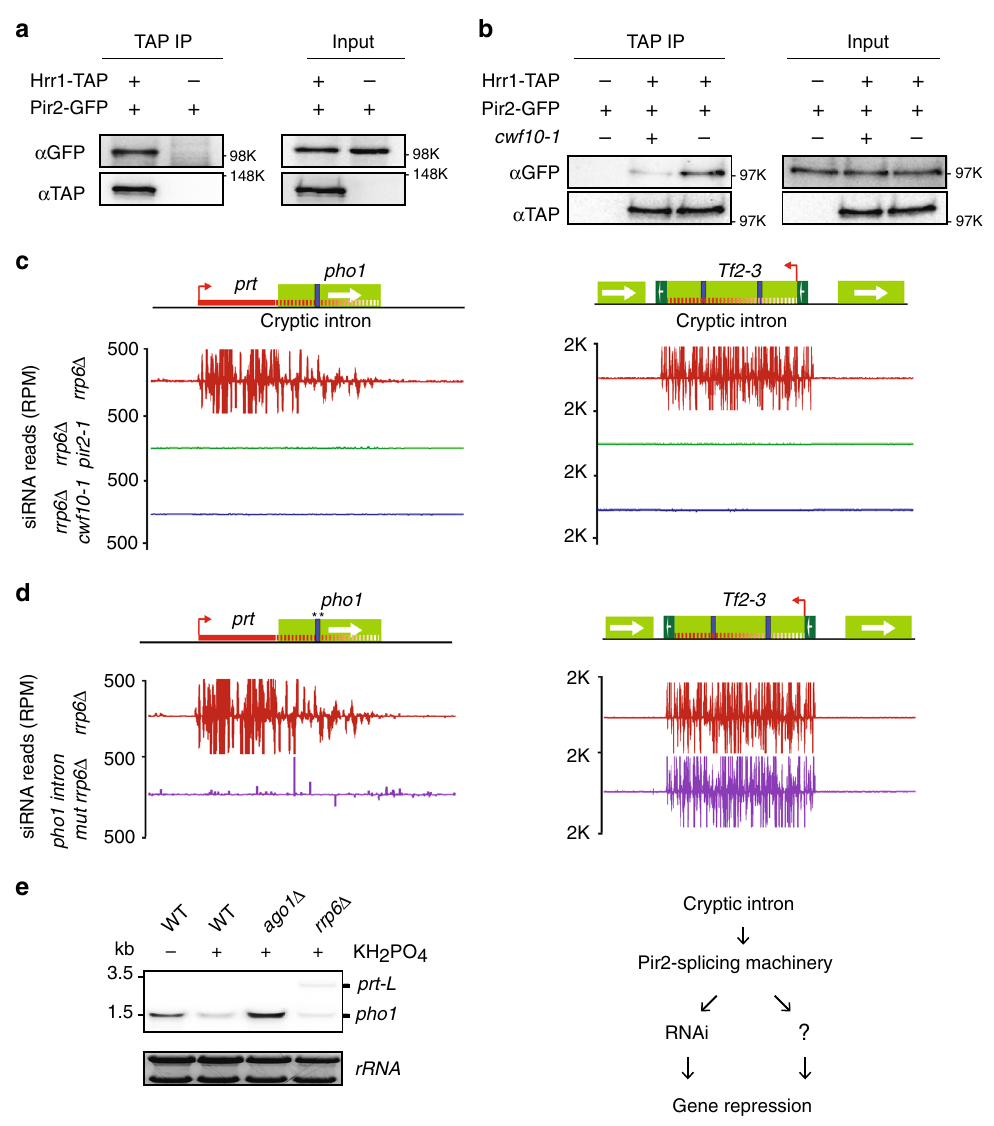
Fig. 4 Pir2 interacts with RNAi machinery required for lncRNA-mediated gene repression. a , b Co-IP analysis of Hrr1-TAP and Pir2-GFP proteins in the indicated strains. Source data are provided as a Source data fi le. c The normalized number of siRNA reads are plotted in alignment with pho1 and Tf2-3 loci. The signal above and below the line represent siRNAs that map to the top and bottom strands, respectively. TopHAT splice junctions of introns emerging in the strains are indicated by blue arcs. d Normalized number of siRNAs mapping to pho1 and Tf2-3 loci in rrp6 Δ (red) and rrp6 Δ cells carrying the splice site mutation in the cryptic intron in prt-pho1 (purple). The cryptic intron is marked by a blue box and stars indicate mutation sites. e Northern blot analysis of the pho1 gene. Cells were grown in EMM medium with or without phosphate. The radioactive probe is described in Fig. 1a. Source data are provided as a Source data fi